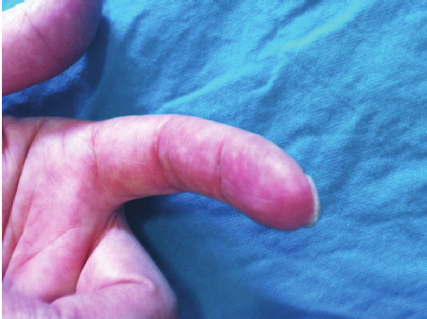
Figure 2: Left hand 2nd fingertip after adalimumab